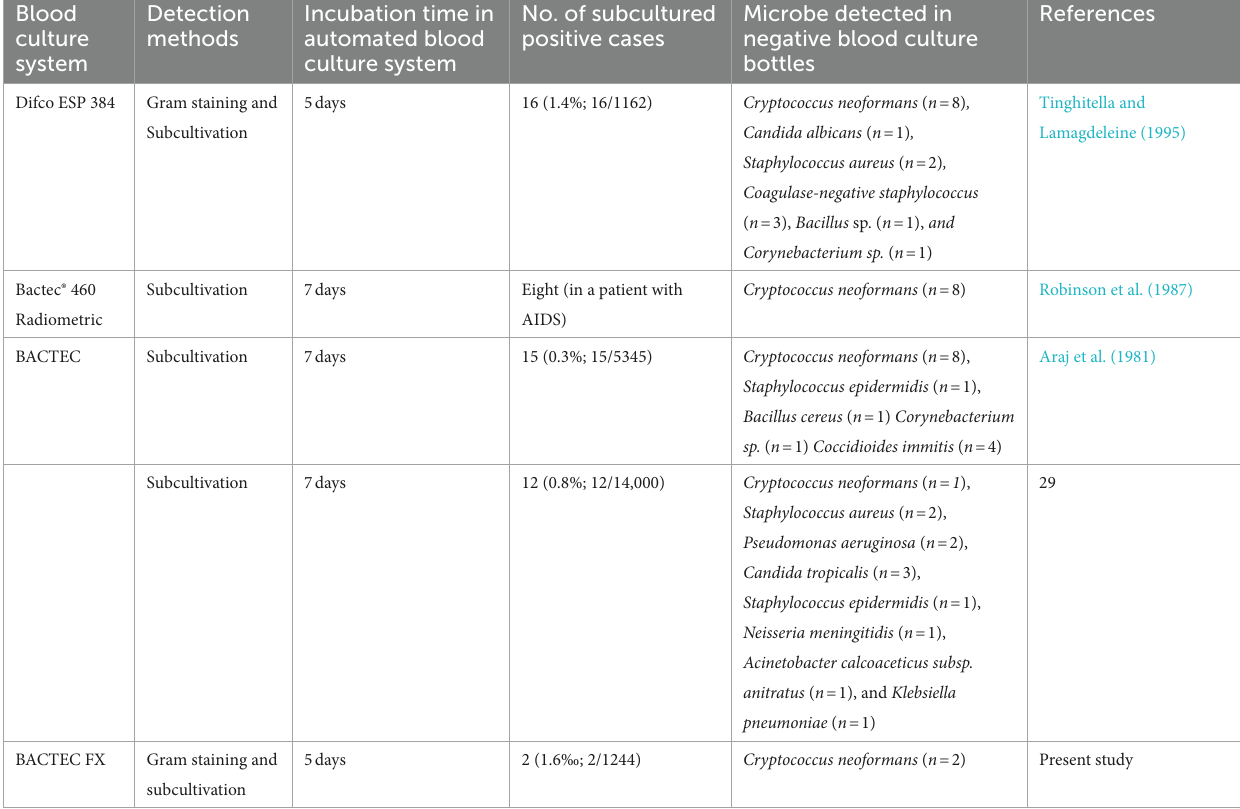
TABLE 2 Literature review of automated blood culture systems that failed to detect Cryptococcus